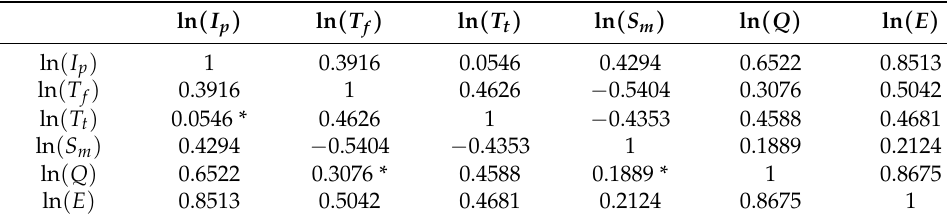
Table 7. Correlation coefficients between lightning parameters.